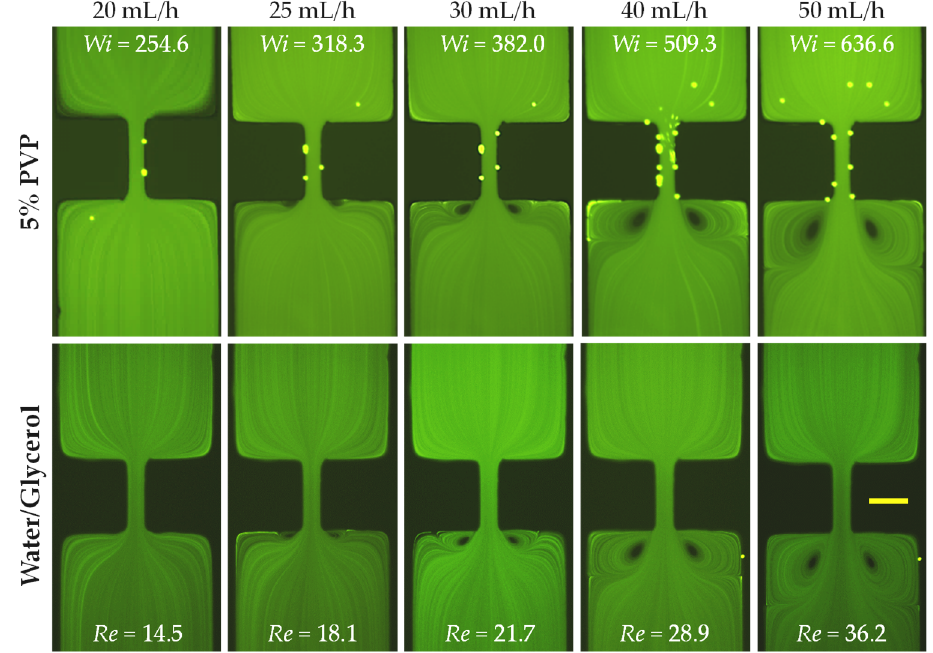
Figure 4. Comparison of the inertial flows (downward) of the viscosity-matched elastic polyvinylpyrrolidone (PVP, 5% in weight, top row) and Newtonian water/glycerol (40/60 in weight, bottom row) solutions at the contraction–expansion region of the microchannel. The scale bar represents 100 µm.